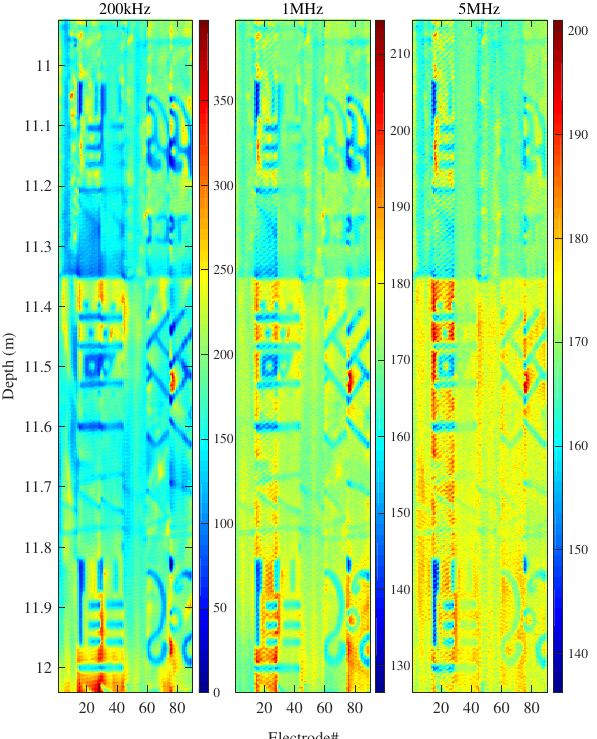
Figure 15. The imaging result of borehole wall patterns with UMMAI sample modulus in the third test, while the borehole is filled with water-oil mixed